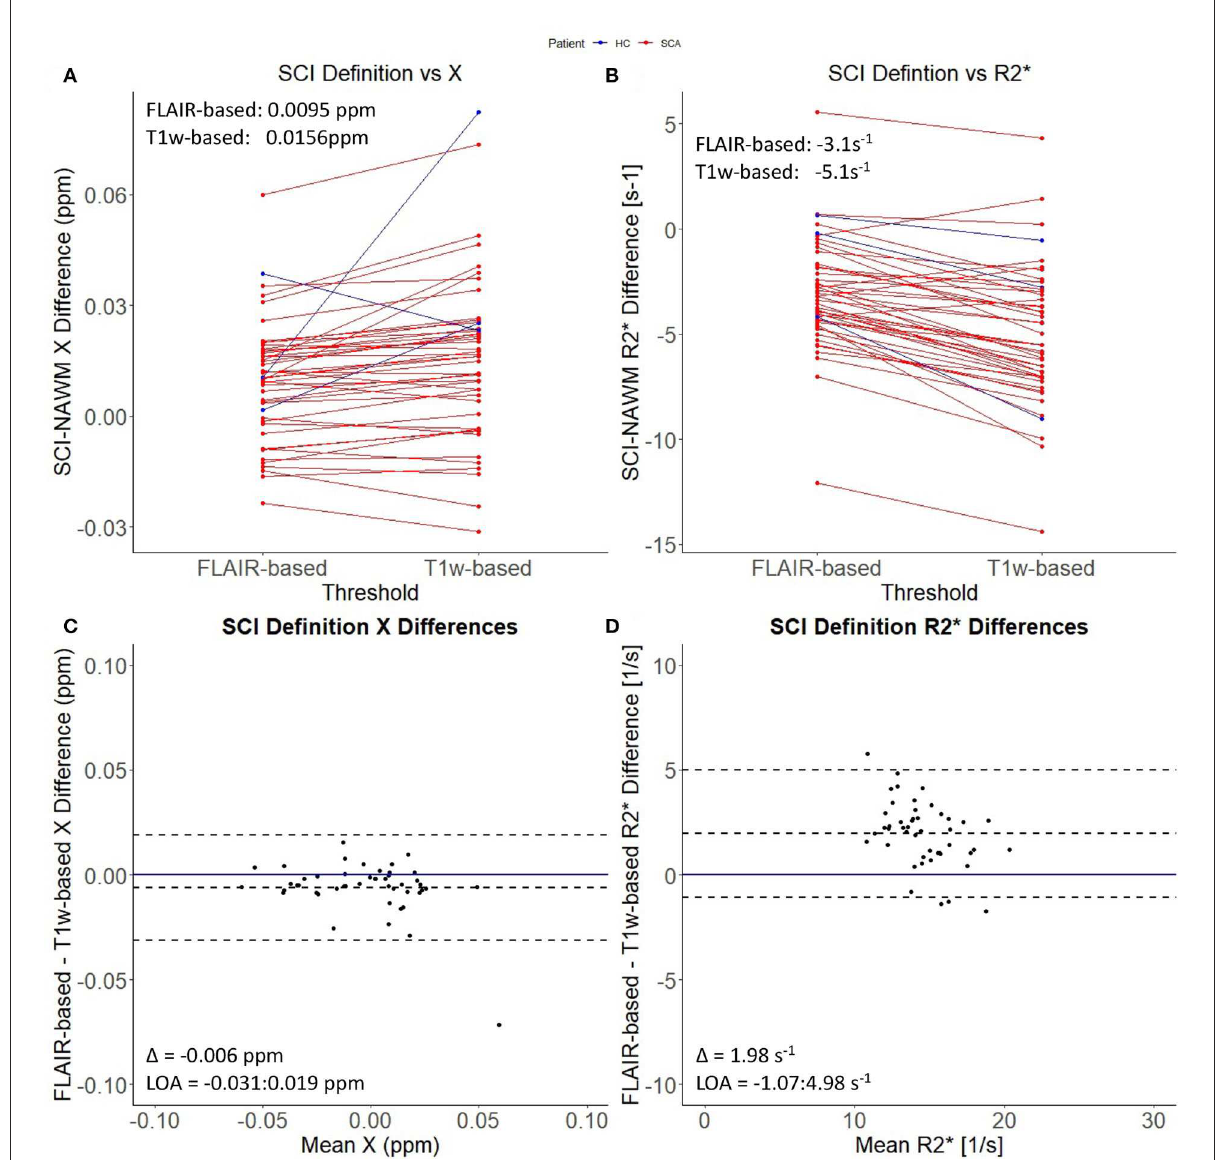
FIGURE4 Effect of SCI definition on SCI-NAWM χ and R * 2 . (A) Comparison of mean silent cerebral infarct (SCI) and normal appearing white matter (NAWM) susceptibility ( χ ) differences before and after the application of the more stringent T1w-based threshold. (B) Comparison of mean SCI-NAWM R2* differences before and after application of the T1w-based threshold. Mean SCI-NAWM χ and R * 2 differences for the two definitions are shows in (A,B) respectively. (C) Bland-Altman analysis of mean SCI-NAWM χ differences before and after application of the T1w-based threshold. The mean bias ( 1 ) and limits of agreement (LOA) are annotated within the plot. (D) Bland-Altman analysis of the mean SCI-NAWM R * 2 differences.